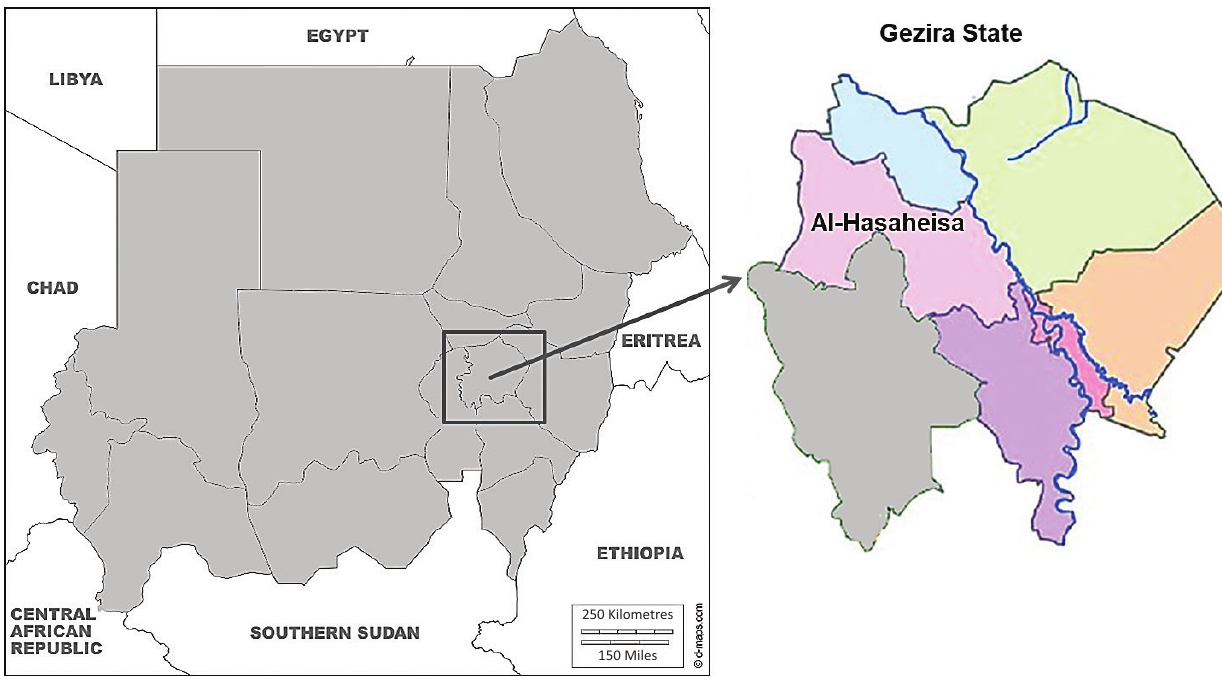
FIGURE 1: Map of Sudan showing the study area ‘Al-Hasaheisa area in Gezira state, central Sudan’.